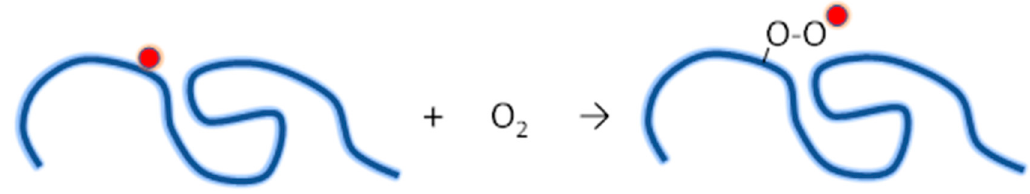
Figure 16. Addition of oxygen molecule to a carbon-centered polymer radical leading to the formation of a peroxyl radical.